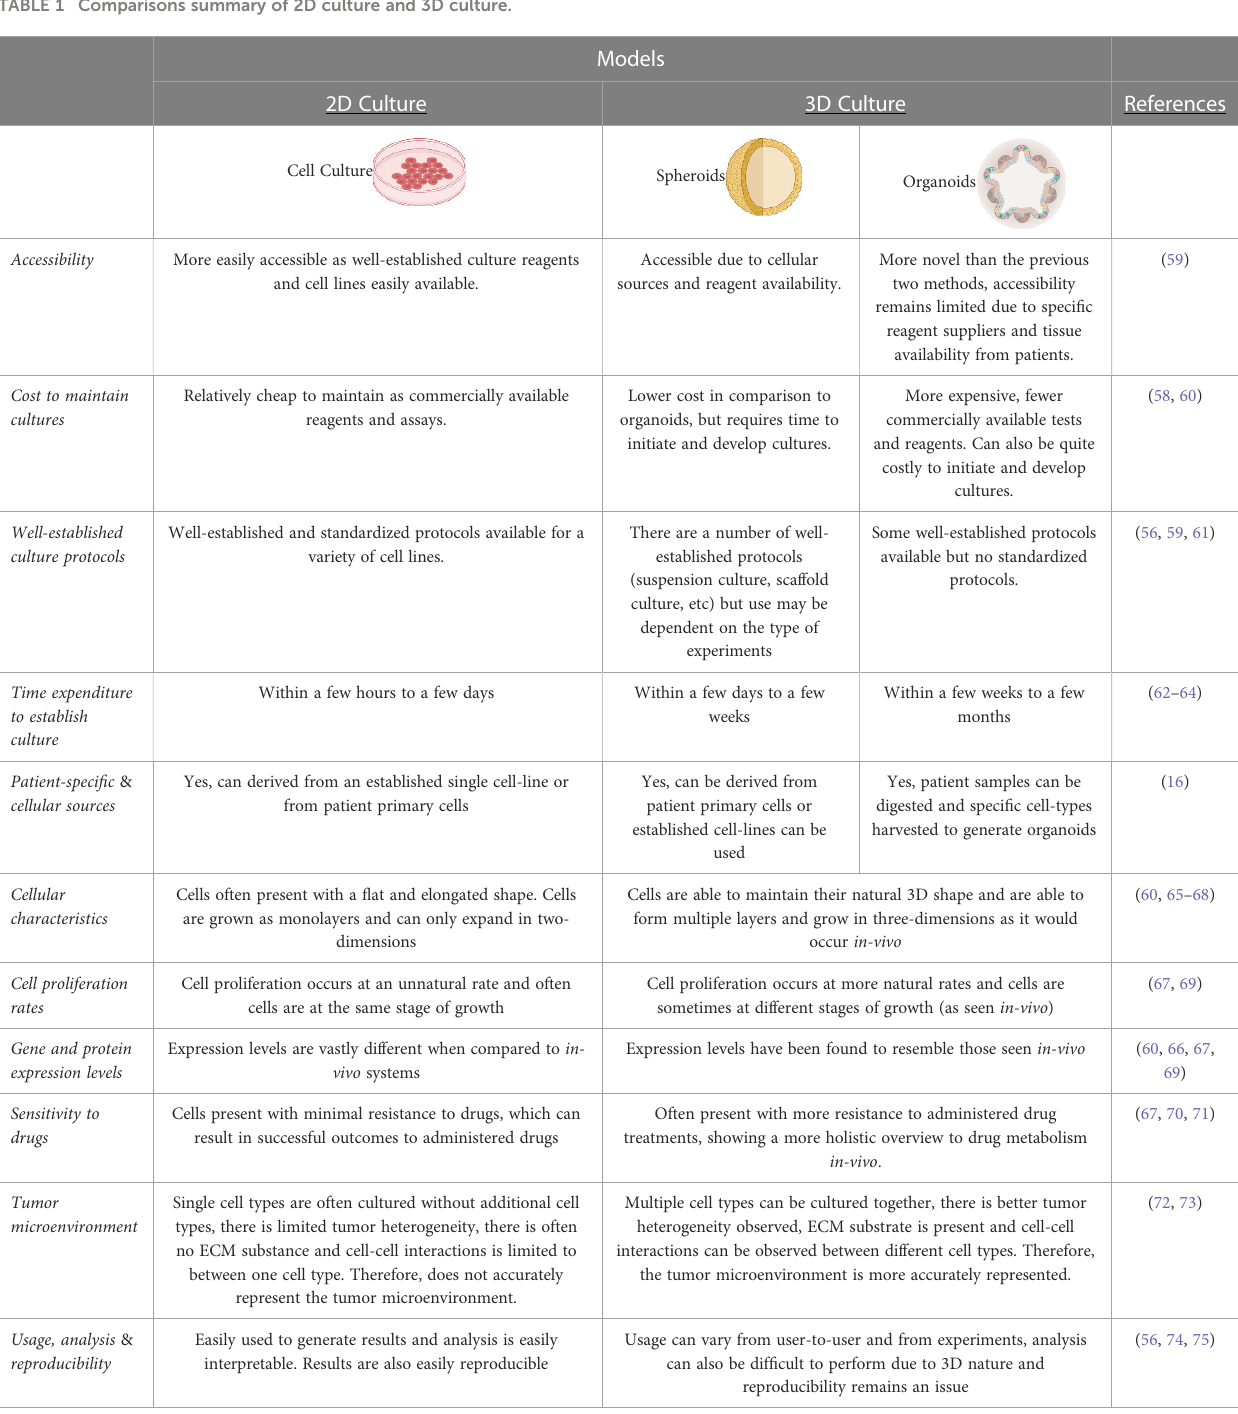
TABLE 1 Comparisons summary of 2D culture and 3D